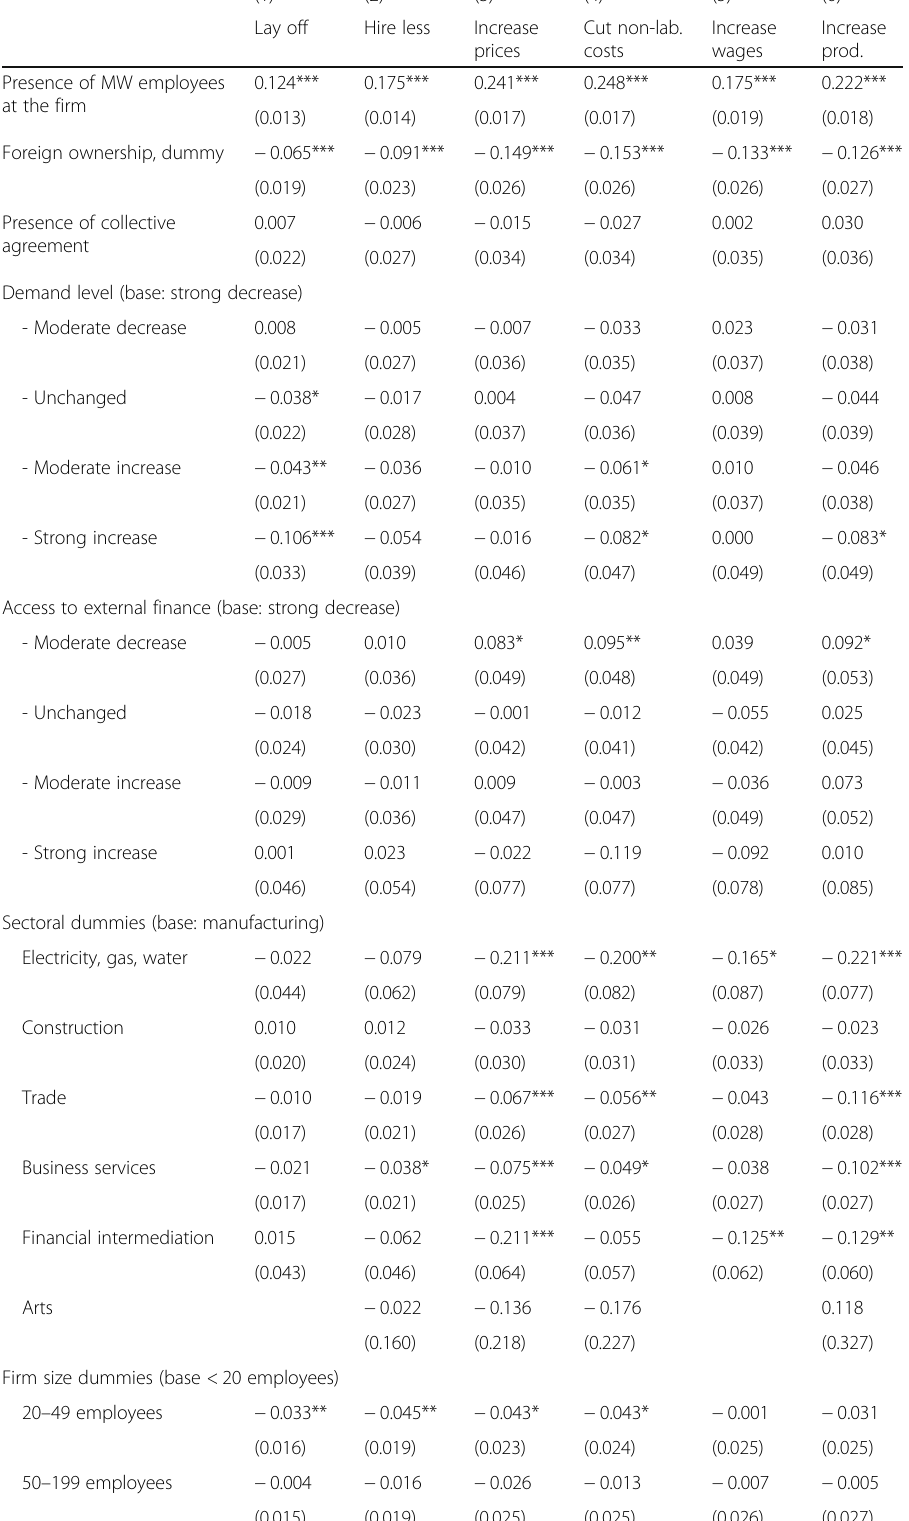
Table 5 Multivariate probit model of the relevance of adjustment channels, average marginal effects (all channels; sample restricted to the Baltic countries and